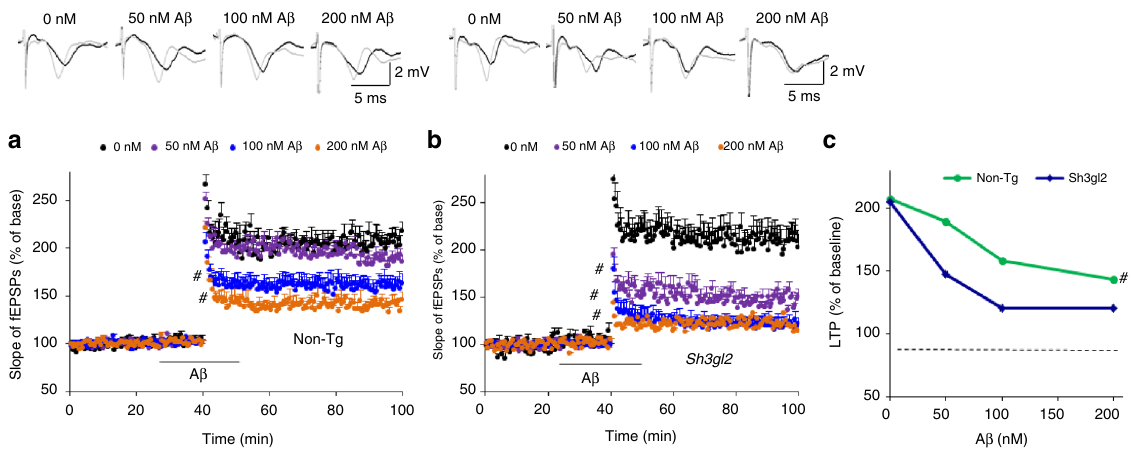
Fig. 1 Effect of EP overexpression on oligomer A β -induced hippocampal synaptic de fi cit. Hippocampal slices were derived from 3-month-old non-Tg and Tg Sh3gl2 mice. Slices were perfused with 50, 100, and 200 nM A β for 1 h . a Fifty nanomolar of oligomer A β perfusion over non-Tg slices does not signi fi cantly reduce LTP level. Perfusion of non-Tg hippocampal slices with higher A β concentration (100 nM, 200 nM) impairs hippocampal LTP expression. Error bars represent s.e.m., n = 7 – 10 per group; # p < 0.05 (one-way ANOVA). b Fifty nanomolar of oligomer A β perfusion over Tg Sh3gl2 slices signi fi cantly reduce the LTP level. Perfusion with higher A β concentration (100 nM, 200 nM) saturated the deleterious effect of A β on hippocampal LTP impairment. Line indicates A β exposure period. Error bars represent s.e.m., n = 7 – 10 per group; # p < 0.05 (one-way ANOVA). c Upper panels of a and b show representative traces of fEPSP in slices with the indicated treatment before θ -burst stimulation (black line) and after 1 h (gray line). Summarized LTP levels (average of the fEPSPs slope of the last 10 min recordings) in the indicated groups. Data are shown as mean ± s.e.m., n = 7 – 10 per group; # p < 0.05 (Student ’ s t test)